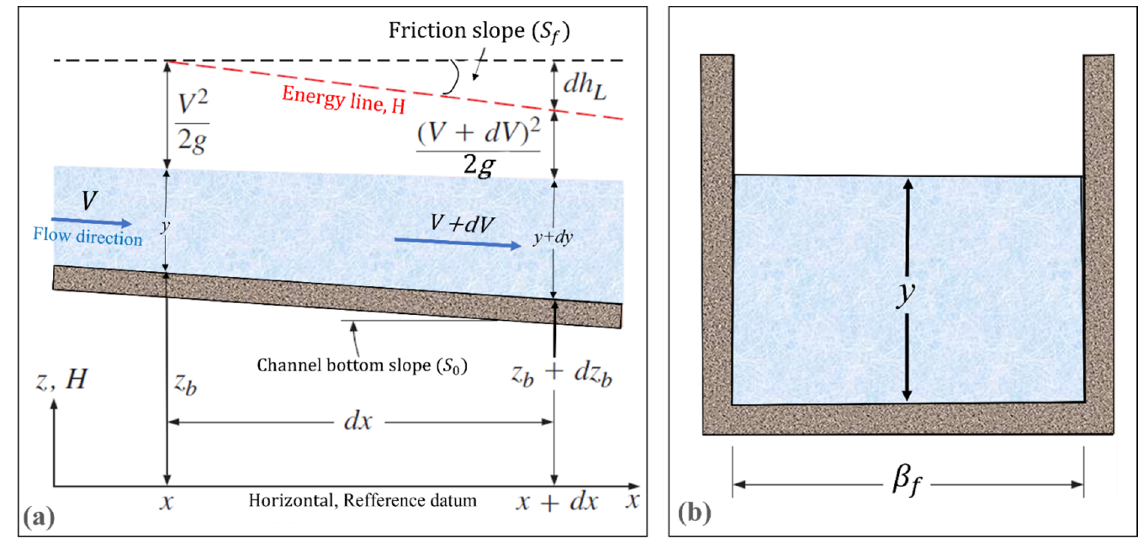
Figure 3. ( a ) Variation of properties over a differential flow section in an open channel. ( b ) Cross-sectional view of the flow channel [19].